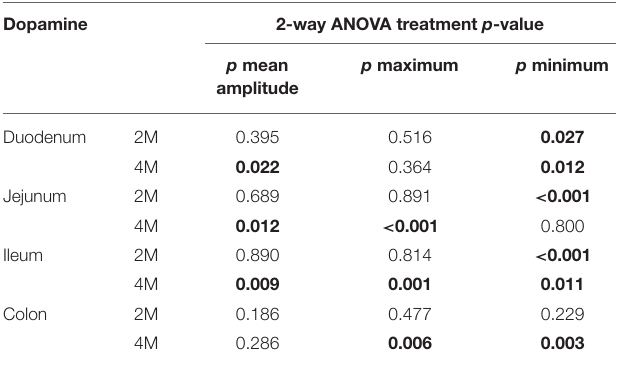
A 2-way ANOVA was used to compare the effect of dopamine on the amplitude, the maximal exerted contraction force, and the muscle tone between vehicle and rotenone- exposed mice. The level of significance is shown as the p-value. Bold values are the significant